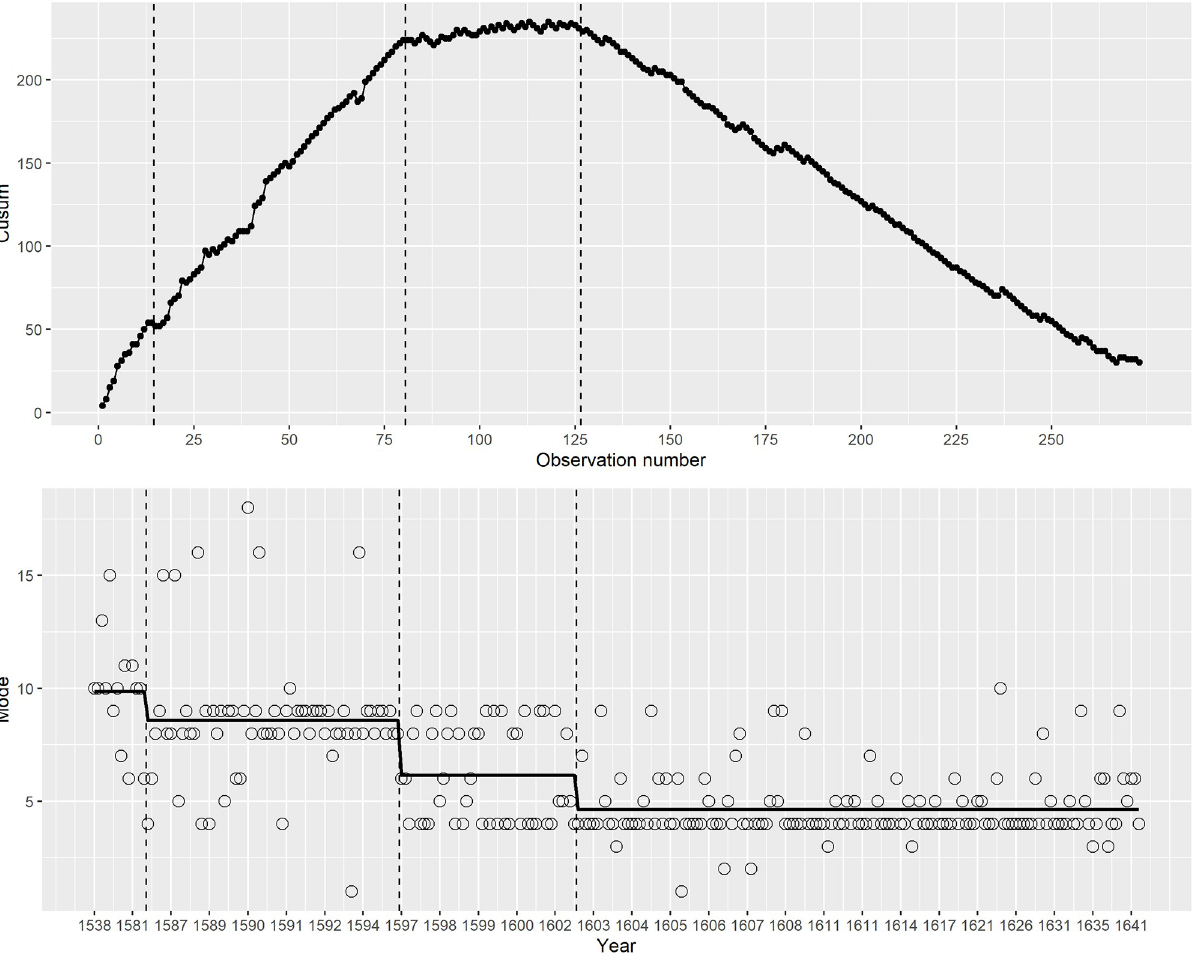
Fig 2. (S1 Fig 2 in S1 File) The upper plot is the cusum plot of mode for each play. The approximately straight-line segments with different slopes indicate the time periods that are interpreted as steps. Time change points are where the line segments change slope. The lower plot is the mode data with the solid line showing the step function interpretation for the mean of the mode using the change points in the cusum plot.